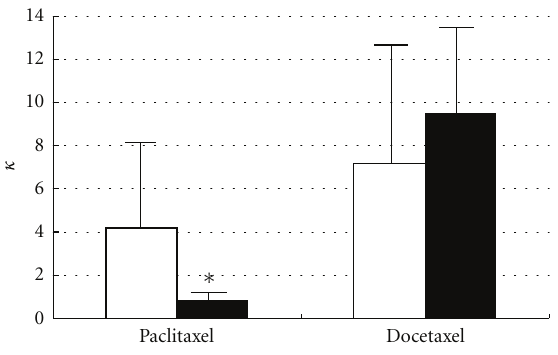
Figure 5: Values of apparent solid tumor to plasma concen- tration ratio (Kp, app) of paclitaxel and docetaxel 1h after an i.p. (40mg/kg, open column) or i.v. (5mg/kg, closed column) injection of Taxol and Taxotere into AH130 tumor-bearing rats [15]. Each column with bar represents the mean ± SD of three rats. ∗ Significantly di ff erent from docetaxel at P < 0 .